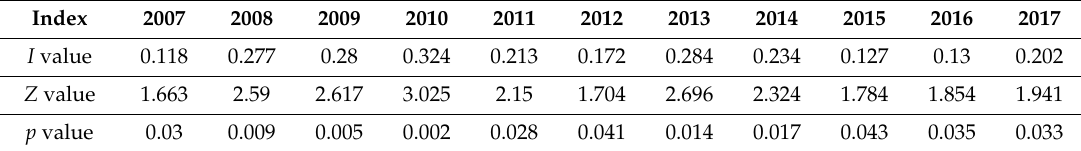
Table 5. Spatial autocorrelation indexes of EFPE values in China